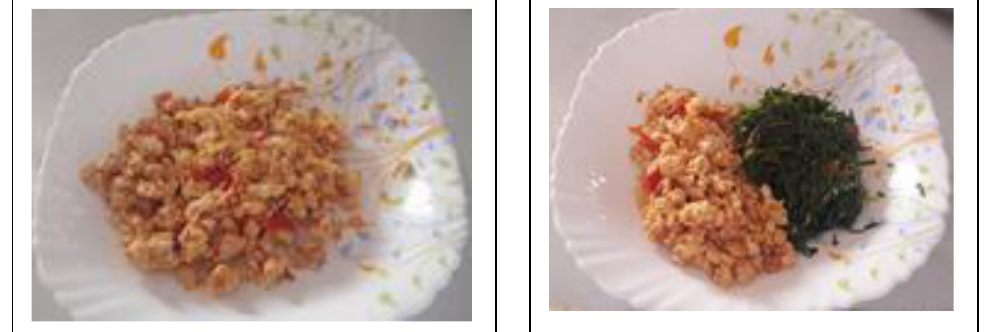
Figure 4: Egg meals prepared as accompaniment for